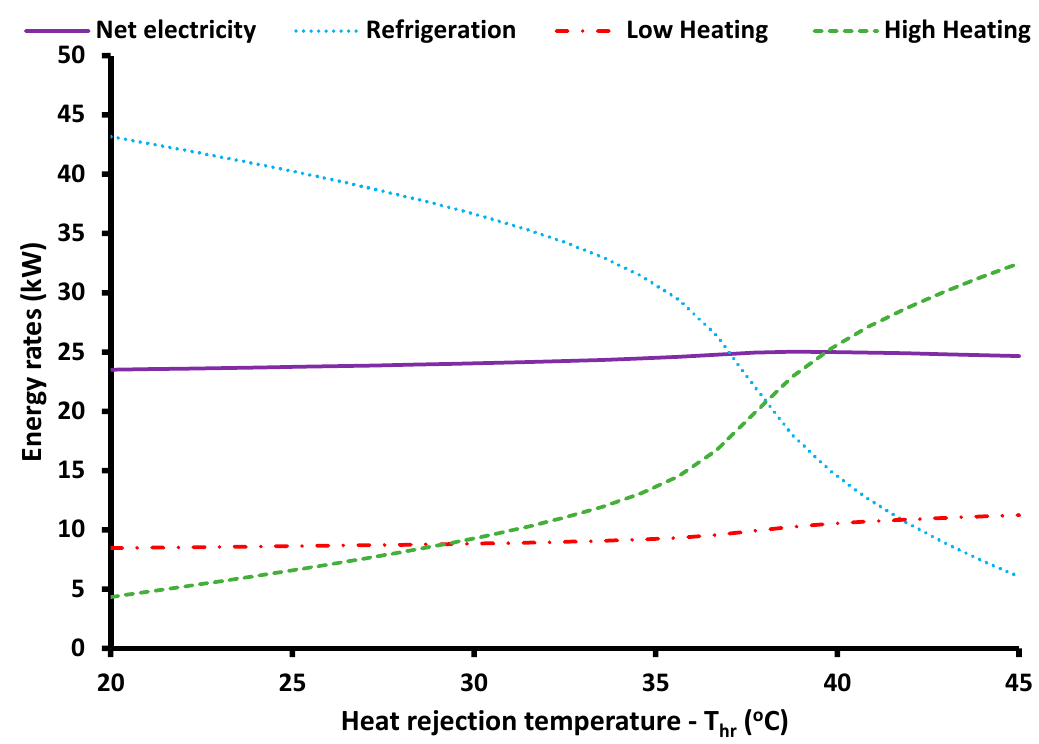
Figure 13. Energy and exergy efficiencies for different values of the refrigeration temperature.